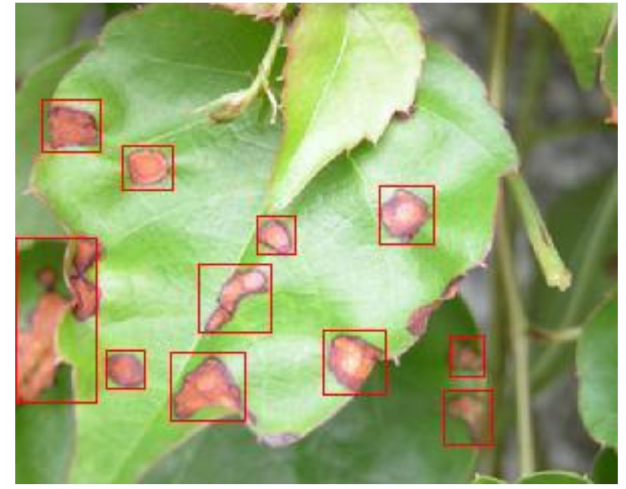
Figure 12. Final detection effect of buckwheat brown spot